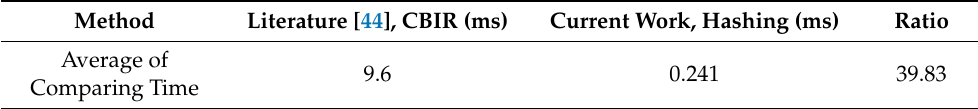
Table 4. Comparing times for different works (equivalent to Step